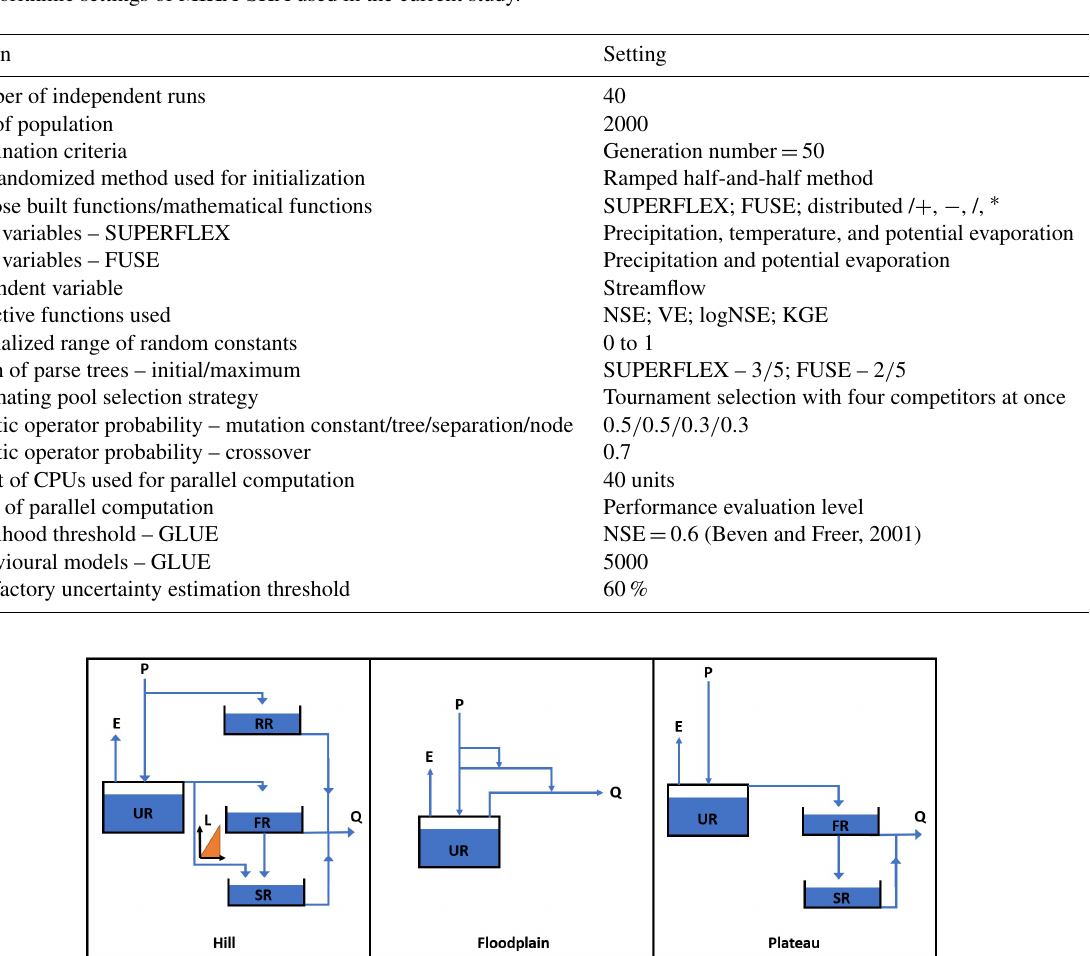
Table 4. Algorithmic settings of MIKA-SHA used in the current study.